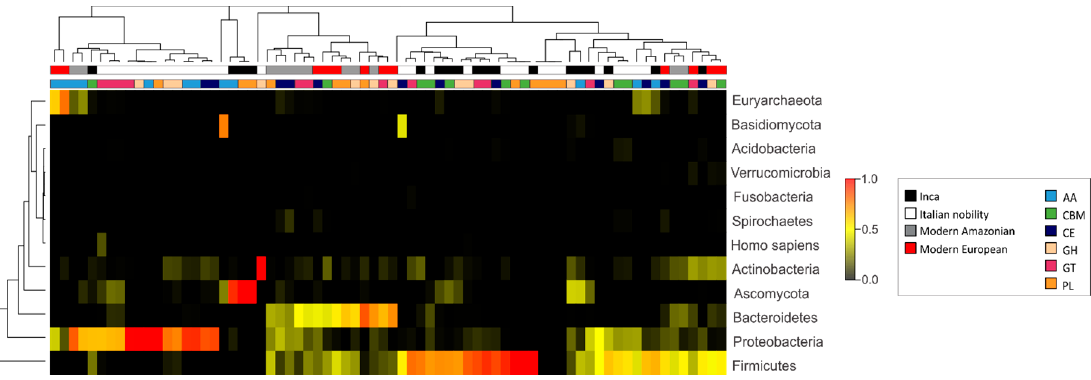
Figure 4. Carbohydrate-active enzymes (CAZyme) gene diversity in the pre-Inca/Inca and Italian nobility mummies guts. Contigs were uploaded to http://www.bioenergycenter.org/besc/index.cfm and annotated using a minimum identity of 80% and e-value of 10 × 10 − 5 . The results represent the Euclidean distance of CAZyme gene counts for a taxon and CAZyme family. Taxon categories were manually curated and classified at the phylum level. Results were also compared to modern Amazonians and modern Europeans.